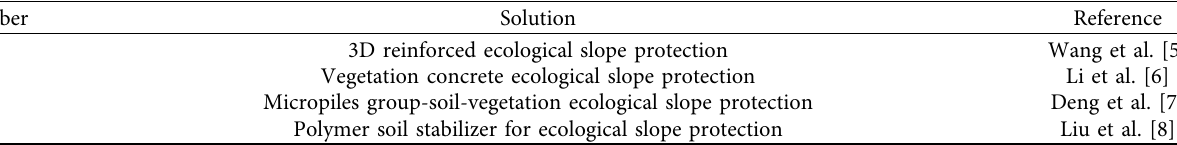
Table 1: Slope protection